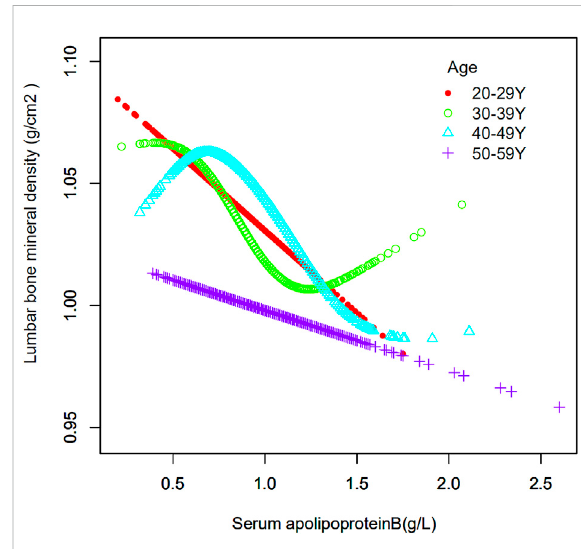
FIGURE 4 Association between serum apolipoprotein B and lumbar bone mineral density strati fi ed by age. Age, race/ethnicity, sex, vigorous recreational activities, smoked at least 100 cigarettes in life, income to poverty ratio, blood urea nitrogen, serum calcium, serum potassium, serum sodium, serum phosphorus, total protein, serum uric acid, body mass index were